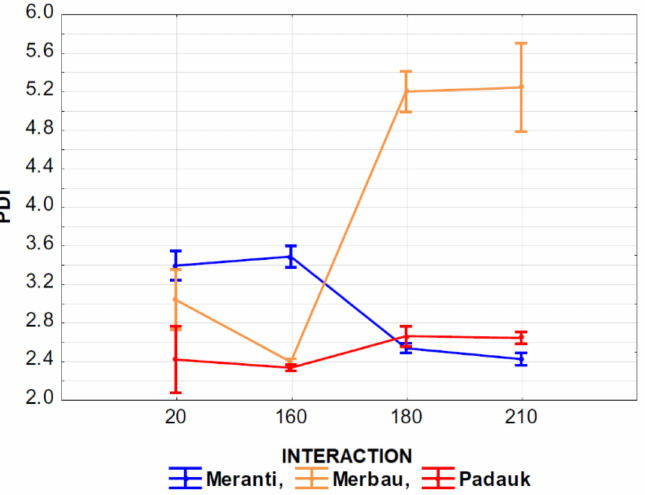
Figure 10. The effect of thermal modification temperature and wood species on polydispersity index.